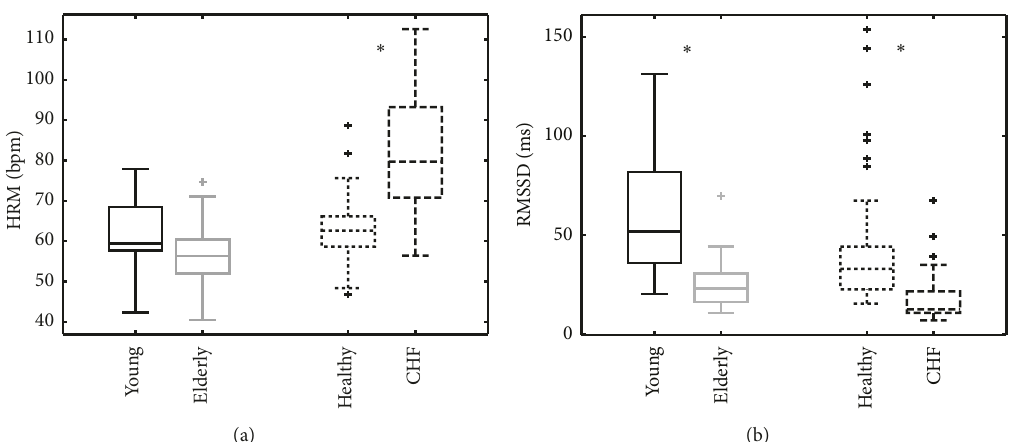
Figure 9: (a) HRM and (b) RMSSD values in young versus elderly and CHF patients versus healthy subjects during the night period. ∗ indicates statistically significant differences by Mann-Whitney U test ( p -values < 0.05) between groups.